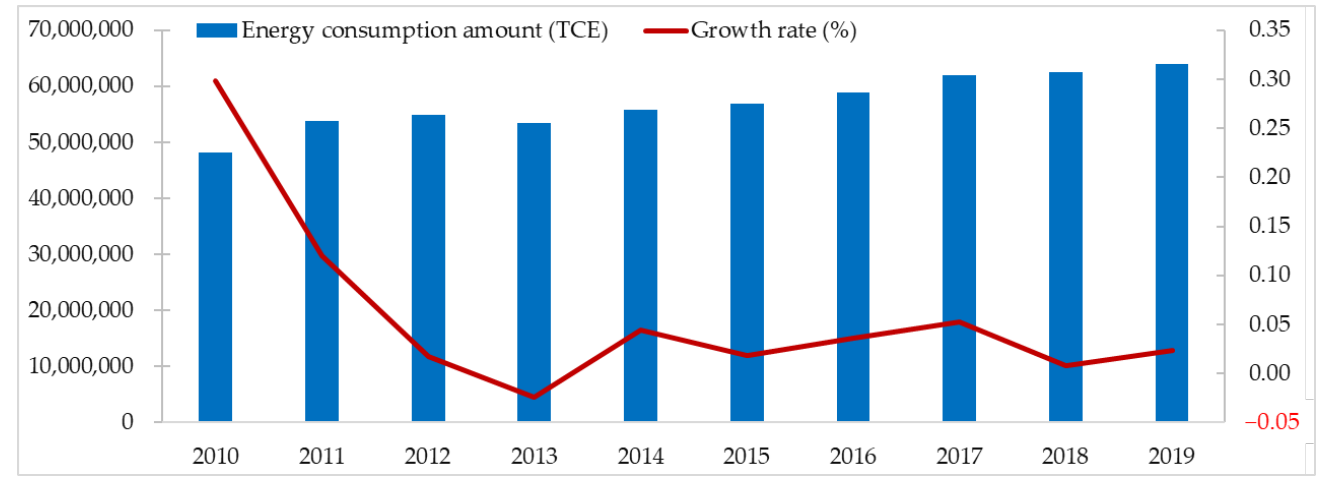
Figure 2. Yearly change and growth rate of ECA on construction industry in China from 2010 to 2019. TCE is a unit of energy measurement which means tons of standard coal equivalent.